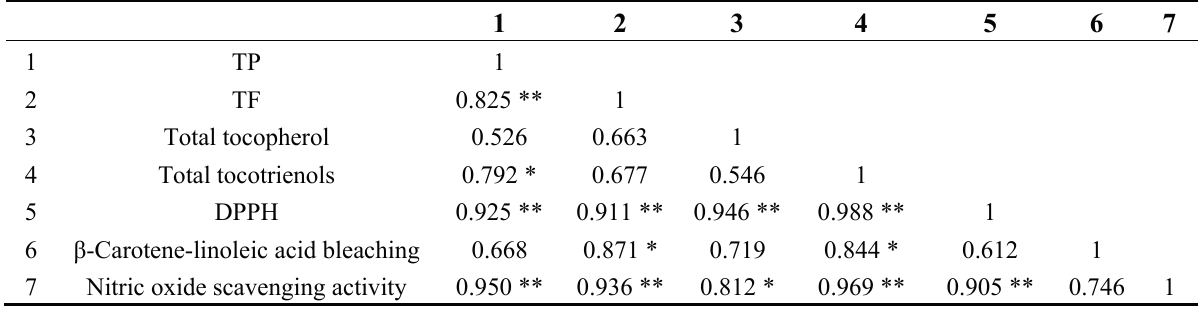
Table 3. Correlatio Hashemi rice